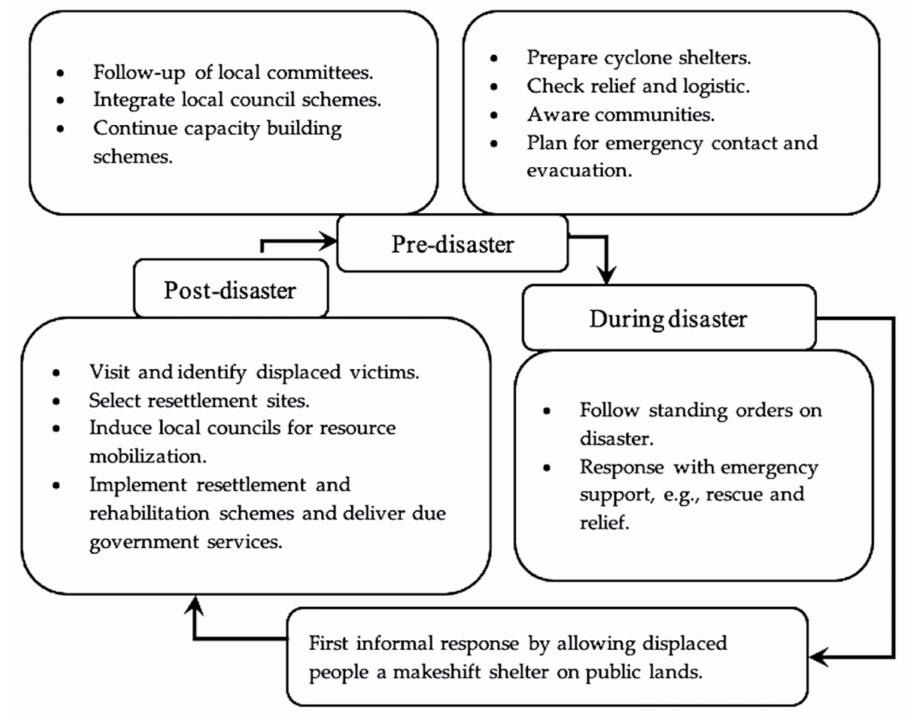
Figure 3. Local officials’ response flow for handling climate-induced displaced